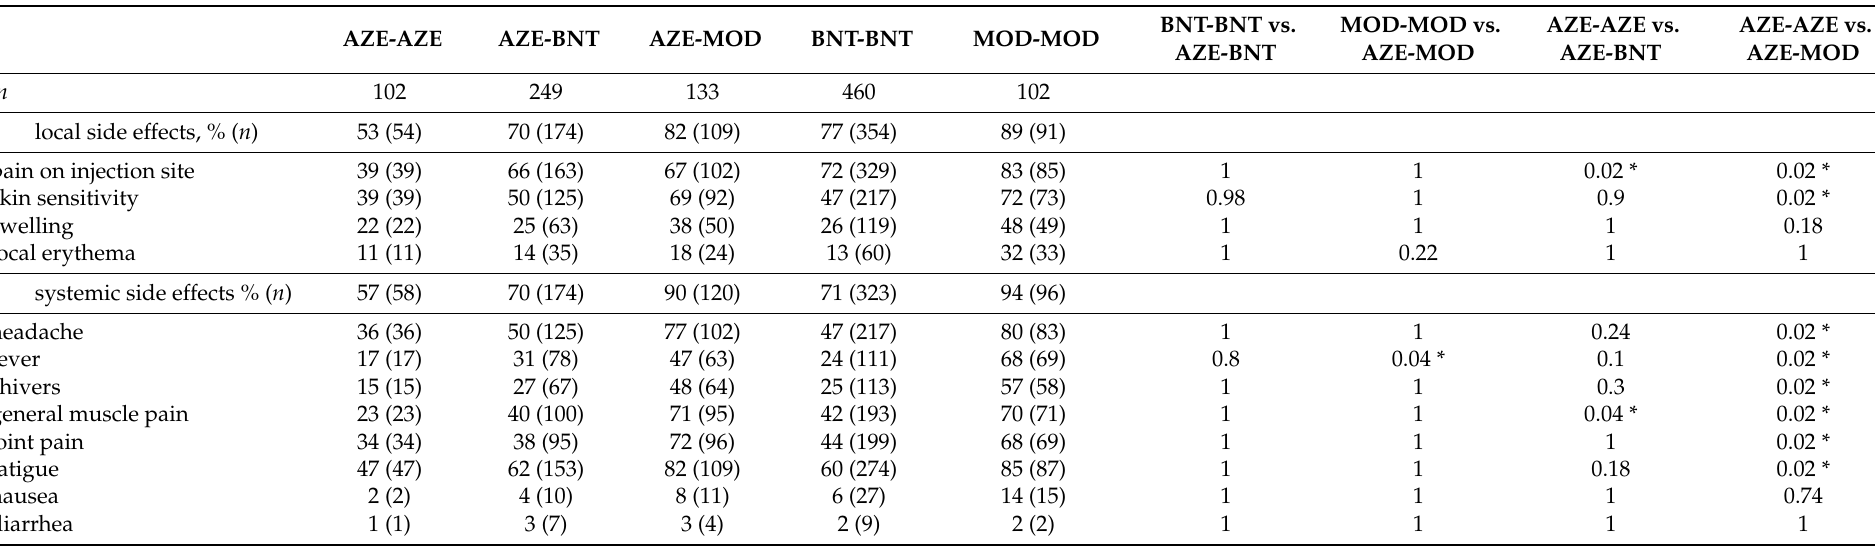
Table 6. Comparison of side effects in terms of symptom frequency after different vaccination schemes (AZE:AstraZeneca (ChAdOx1 nCov19); BNT: Biontech/Pfizer (BNT162b2); MOD: Moderna (mRNA-1273)). The table shows the percentage of vaccinees that reported any local or systemic SE, as well as each symptom, respectively, and the corresponding p -values of inter-scheme analysis after the Bonferroni correction (20 × ). Asterisks indicate statistical